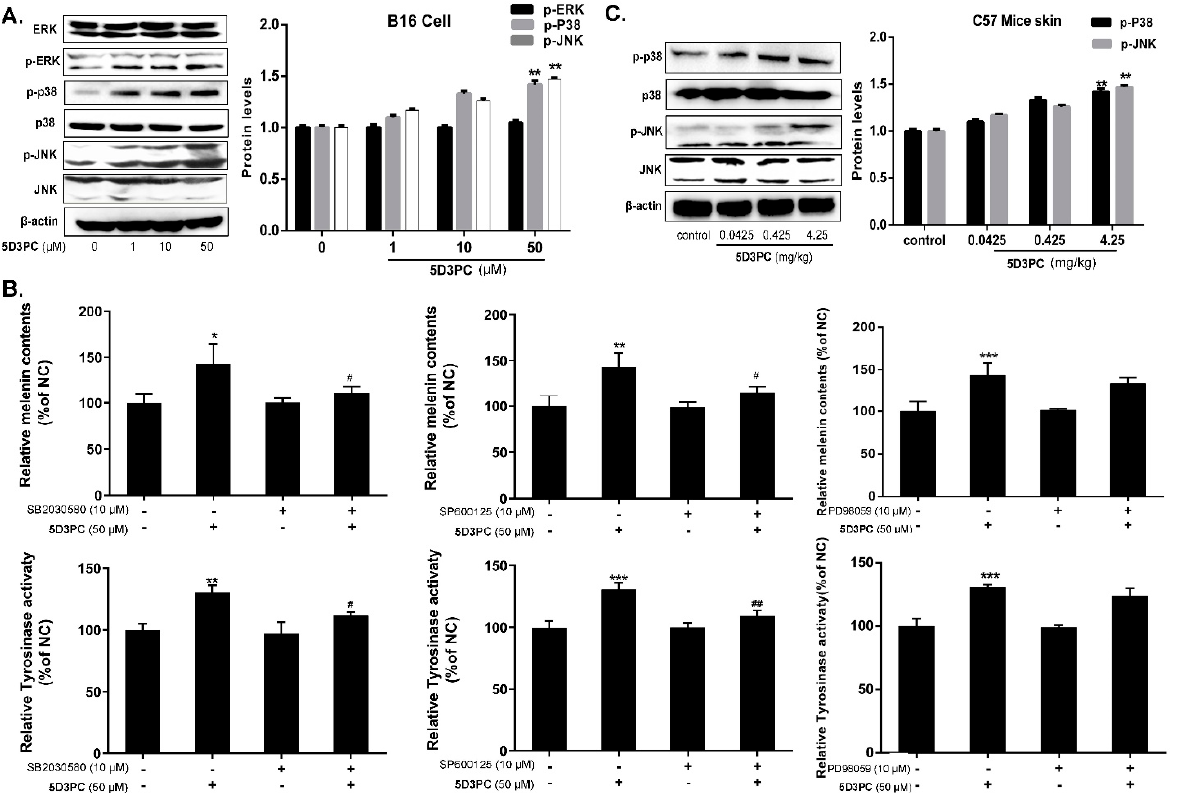
Figure 6. 5D3PC activates p38MAPK and SAPK/JNK. ( A ) WB analysis for the expressions of p-P38, p-JNK, and p-ERK in B16 cells treated with different concentrations (0-50 μ M) of 5D3PC. ( B ) B16 cells were pretreated with SP600125 (a JNK inhibitor), SB203580 (a p38MAPK inhibitor), and ERK inhibitor (PD98059) for 2 h and then incubated with 5D3PC (50 μ M) for 48 h to measure the melanin contents and 24 h to measure TYR activity. ( C ) The levels of p-P38 and p-JNK were determined by WB analysis in C57BL/6 mouse model treated with 5D3PC. All results are expressed as mean ± SD; statistical analysis was performed with one-way ANOVA, followed by Tukey’s multiple compari- sons test. * p < 0.05, ** p < 0.01, *** p < 0.001. # p < 0.05, and ## p < 0.01 compared with only treated with 5D3PC.